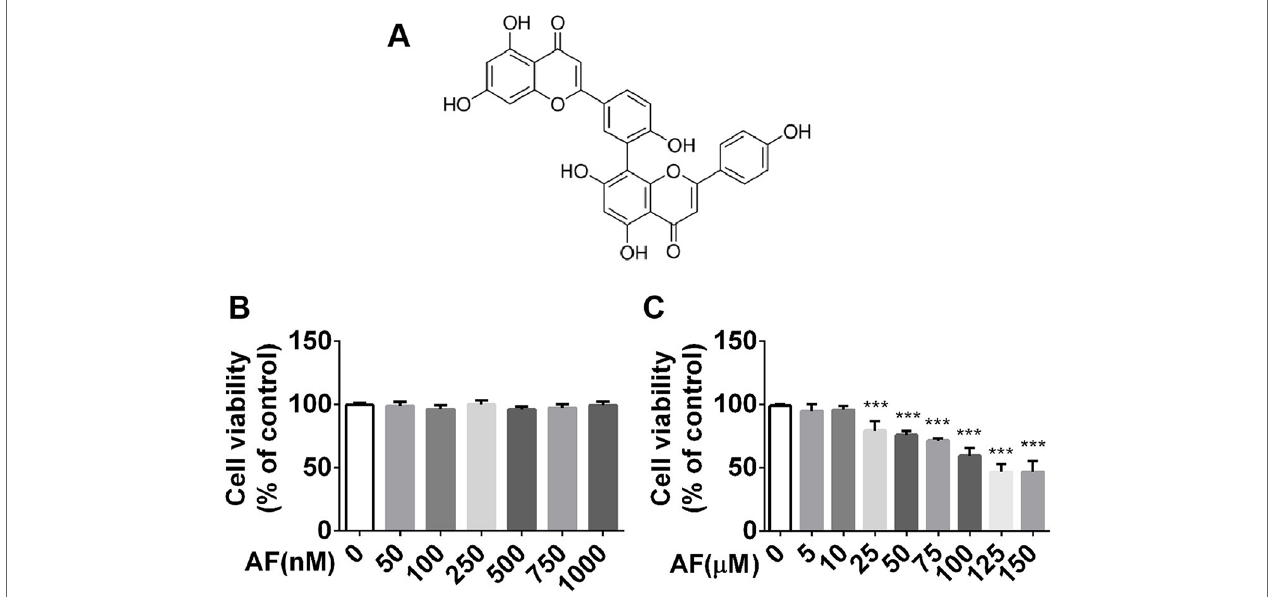
FIGURE 6 | MTT analysis of the effect of amentoflavone on viability of BV2 microglial cells. (A) Structure of amentoflavone. (B) Viability of BV2 microglial cells treated with amentoflavone in graded concentrations (0, 50, 100, 250, 500, 750, or 1000 nM) was measured by MTT assay (one-way ANOVA followed by Dunnett’s test ). (C) Viability of BV2 microglial cells treated with amentoflavone in graded concentrations (5, 10, 25, 50, 75, 100, 125, and 150 µM) was measured by MTT assay (one-way ANOVA followed by Dunnett’s test ). Error bars represent mean ± s.d. Compared to control group, *** represents p < 0.001. All experiments were performed in triplicate. AF,